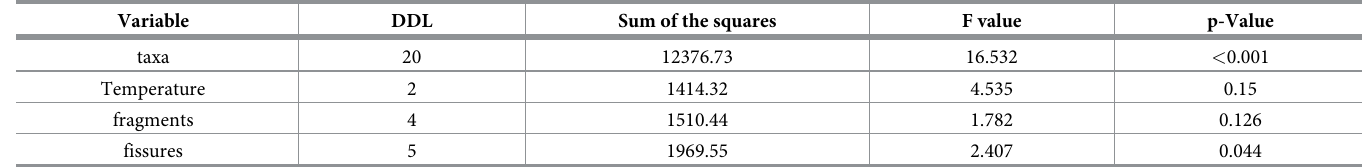
Table 2. Effect of taxa, temperature, and the number of fragments and fissures after in charring experimenton on fragmentation in compression experiment (ANOVA). Variable